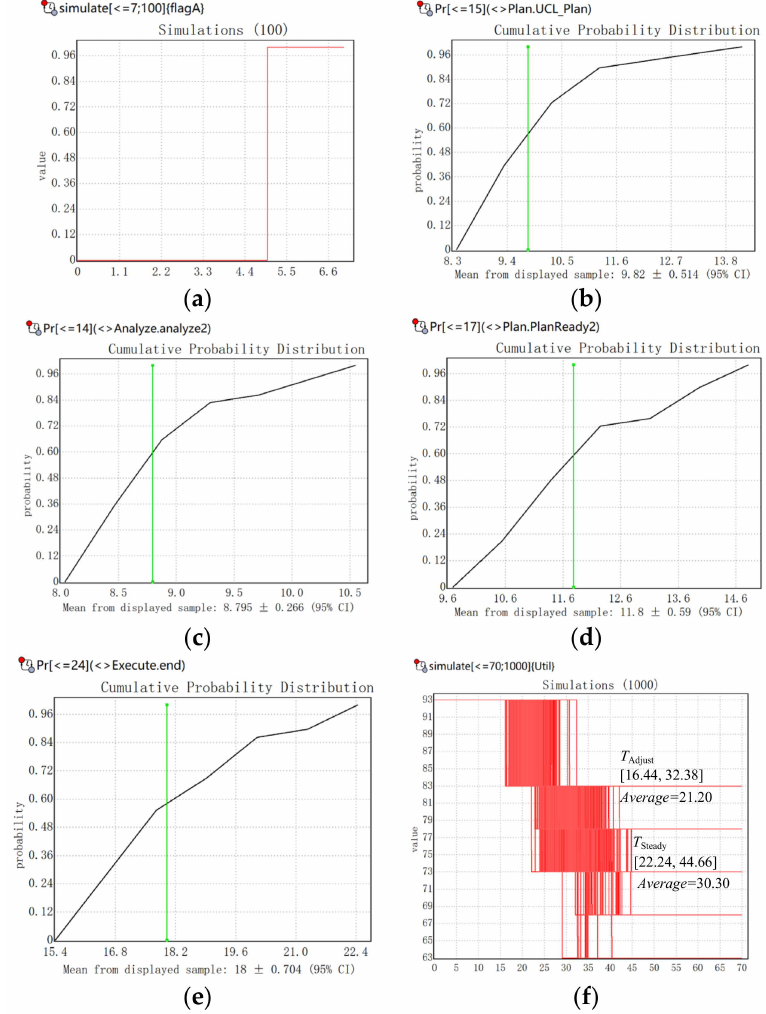
Figure 11. Quantitative analysis of the SUIS example: ( a ) self-adaptation reachability analysis; ( b ) self-adaptation strategy reachability analysis; ( c ) Triggering-Delay Time Analysis; ( d ) Uncertainty Delay Time (Plan) Analysis; ( e ) Uncertainty Delay Time (Execute) Analysis; and ( f ) Self-adaptive Adjusting Time and Self-adaptive Steady Time Analysis.